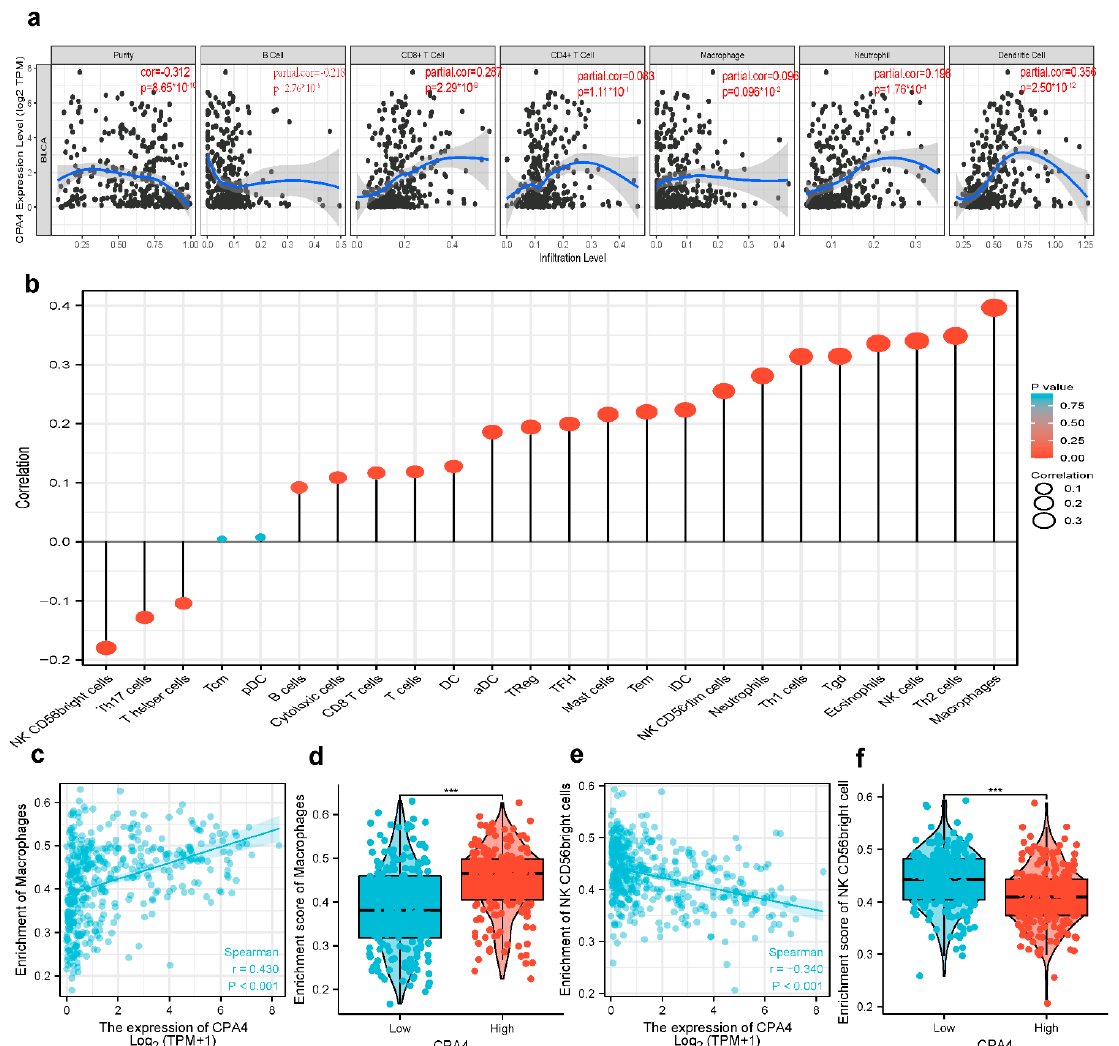
Figure 8. The expression level of CPA4 was related to immune infiltration in the tumor microenvironment. ( a ) Correlation of CPA4 expression with infiltrating immune infiltration in BLCA ( b ) The forest plot shows the correlation between CPA4 expression level and 24 immune cells. The size of the dots indicates the absolute value of Spearman’s R. ( c , d ) The Wilcoxon rank sum test was used to analyze the difference in the macrophage cell infiltration levels between the CPA4 high- and low-expression groups; ( e , f ) the correlation between CPA4 expression and NK CD56 bright cell infiltration levels. *** p <